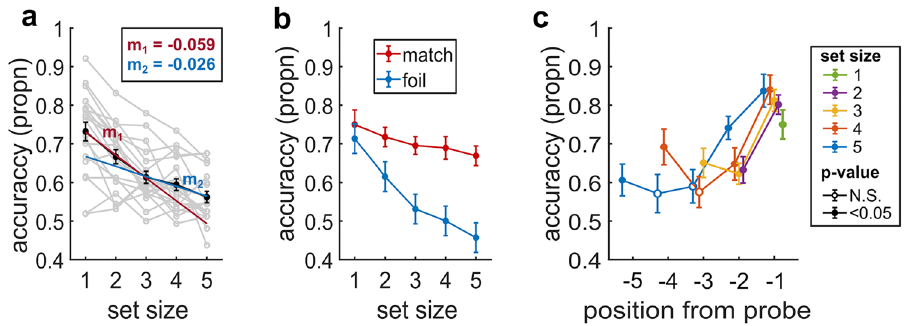
Figure 4. Recognition accuracy in Experiment 2. ( a ) Recognition accuracy across set sizes. The red line is fitted to the first three data points with a slope (m 1 ) of − 0.059, and the blue line is fitted to the last three data points with a slope (m 2 ) of − 0.026. ( b ) Recognition accuracy of match and foil trials across set size. ( c ) Serial positions for match trials. Recognition accuracy for each item in a given set size relative to the probe. I.e., in set size 5, the first item presented is at position − 5 from the probe. Accuracy is the proportion of correct responses (propn). Data points are means, error bars are SEM. Gray lines represent single-subject data (N = 20). Filled circles represent accuracy significantly above chance (p < 0.05); open circles represent accuracy not significantly above